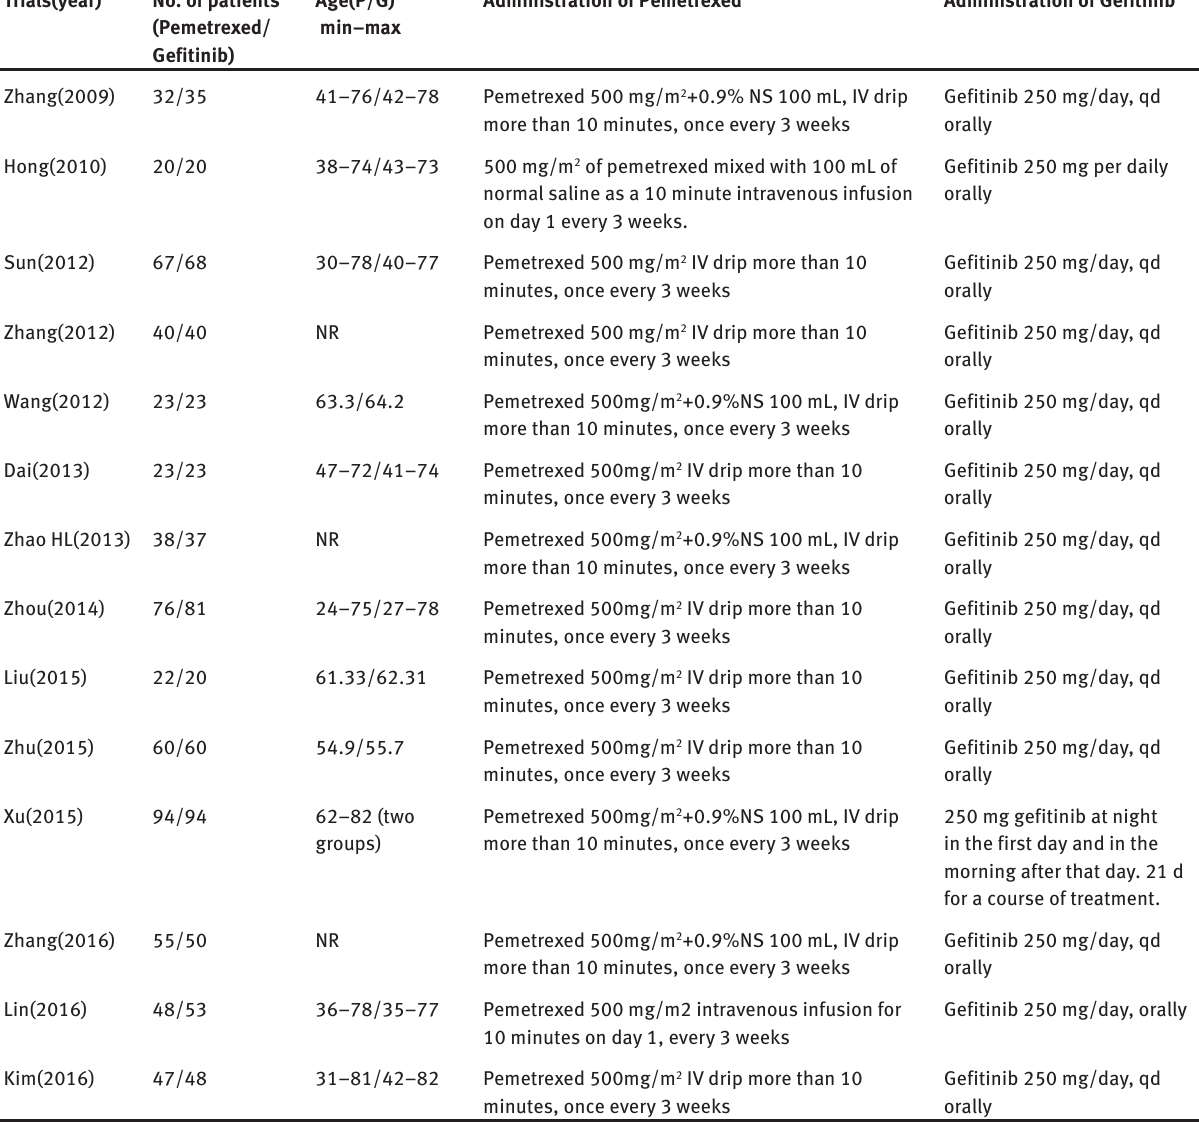
Table 1: Main characters of the included 14 trials. Trials(year) No. of